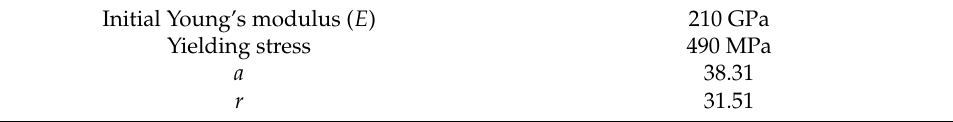
Figure 13. Ramberg–Osgood stress–strain curve for steel API5L-X65. Table 2. Parameters of Ramberg–Osgood stress–strain for steel